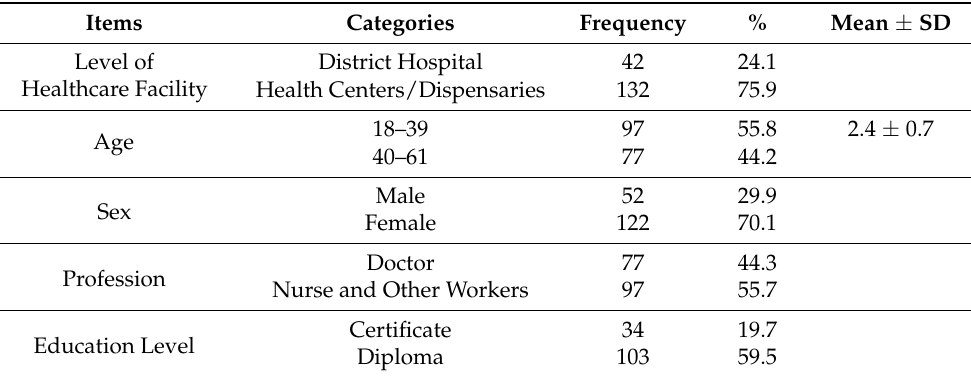
Table 1. Sociodemographic characteristics of healthcare providers.